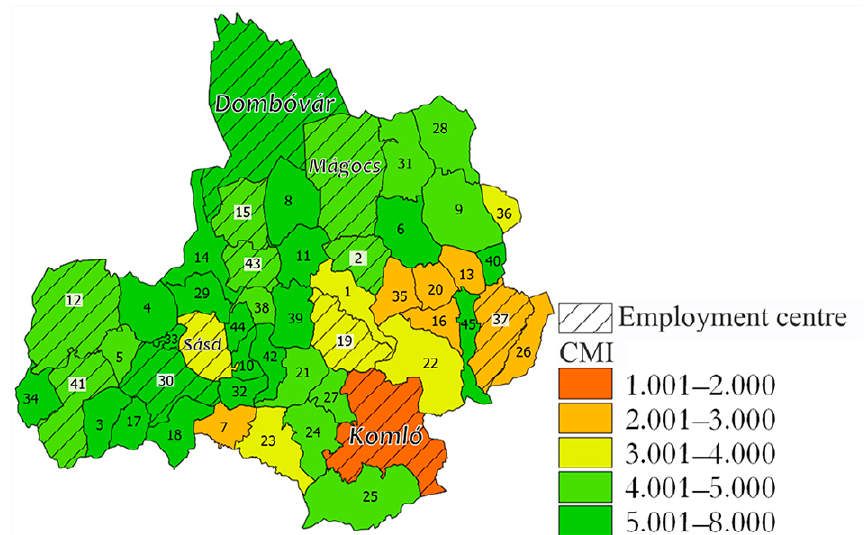
Figure 4. Modified CMI-values including transport subsidies (internal model)